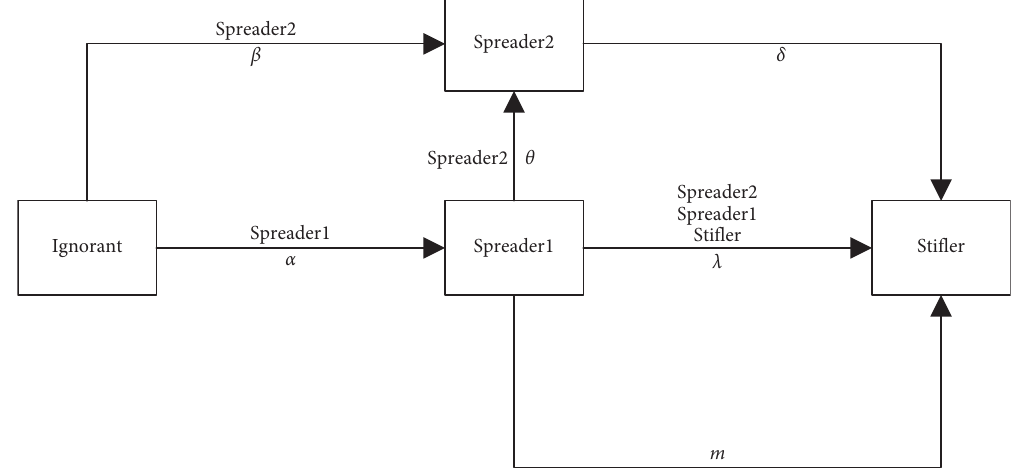
Figure 1: 2SIR rumor propagation